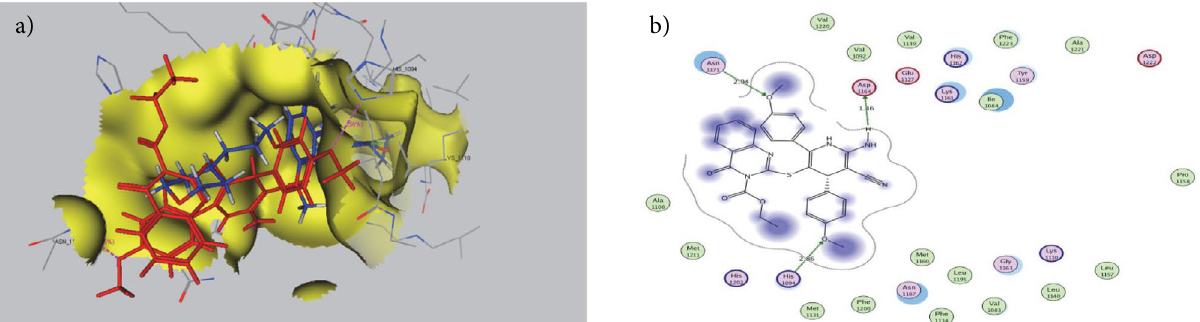
Figure 4. (a) The superposition of foretinib (blue) and compound 21e (red) docked in the binding site of c-Met, the dotted lines represent H-bond- ing interactions; (b) 2D ligand interaction of 21e in binding site of